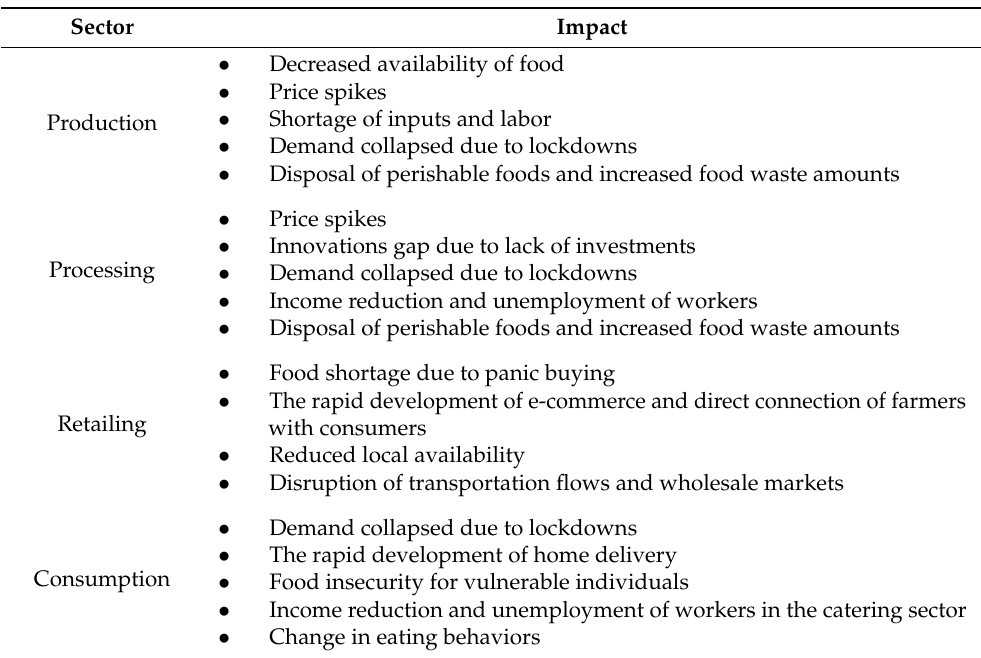
Table 1. Impact of the COVID-19 pandemic on the food